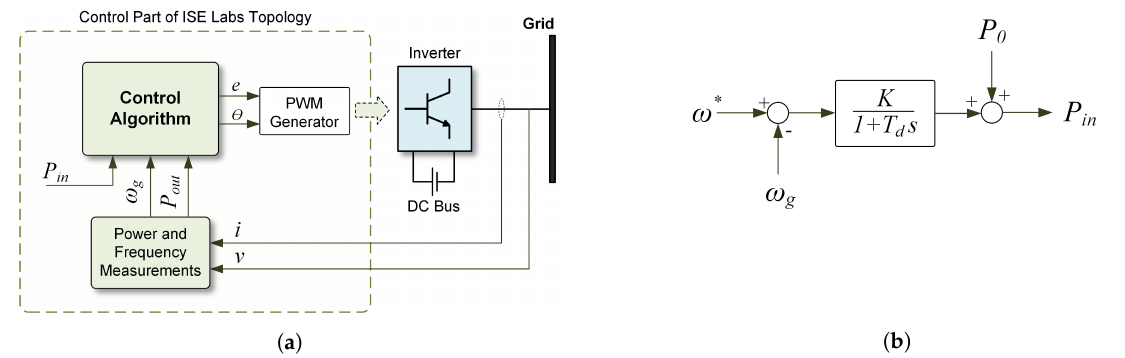
Figure 8. Ise Lab’s topology: ( a ) overall schematic showing operating principle; ( b ) the governor model to compute input